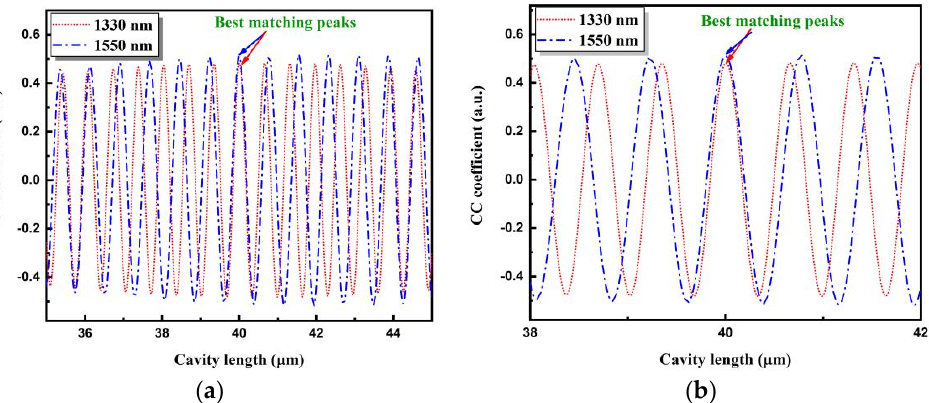
Figure 5. Cross-correlation curves of the 40 μ m fiber-optic F–P sensor corresponding to two spectral ranges. ( a ) The template cavity length range is 35–45 μ m. ( b ) The neighboring range of the best matching point is enlarged. CC: cross-correlation.